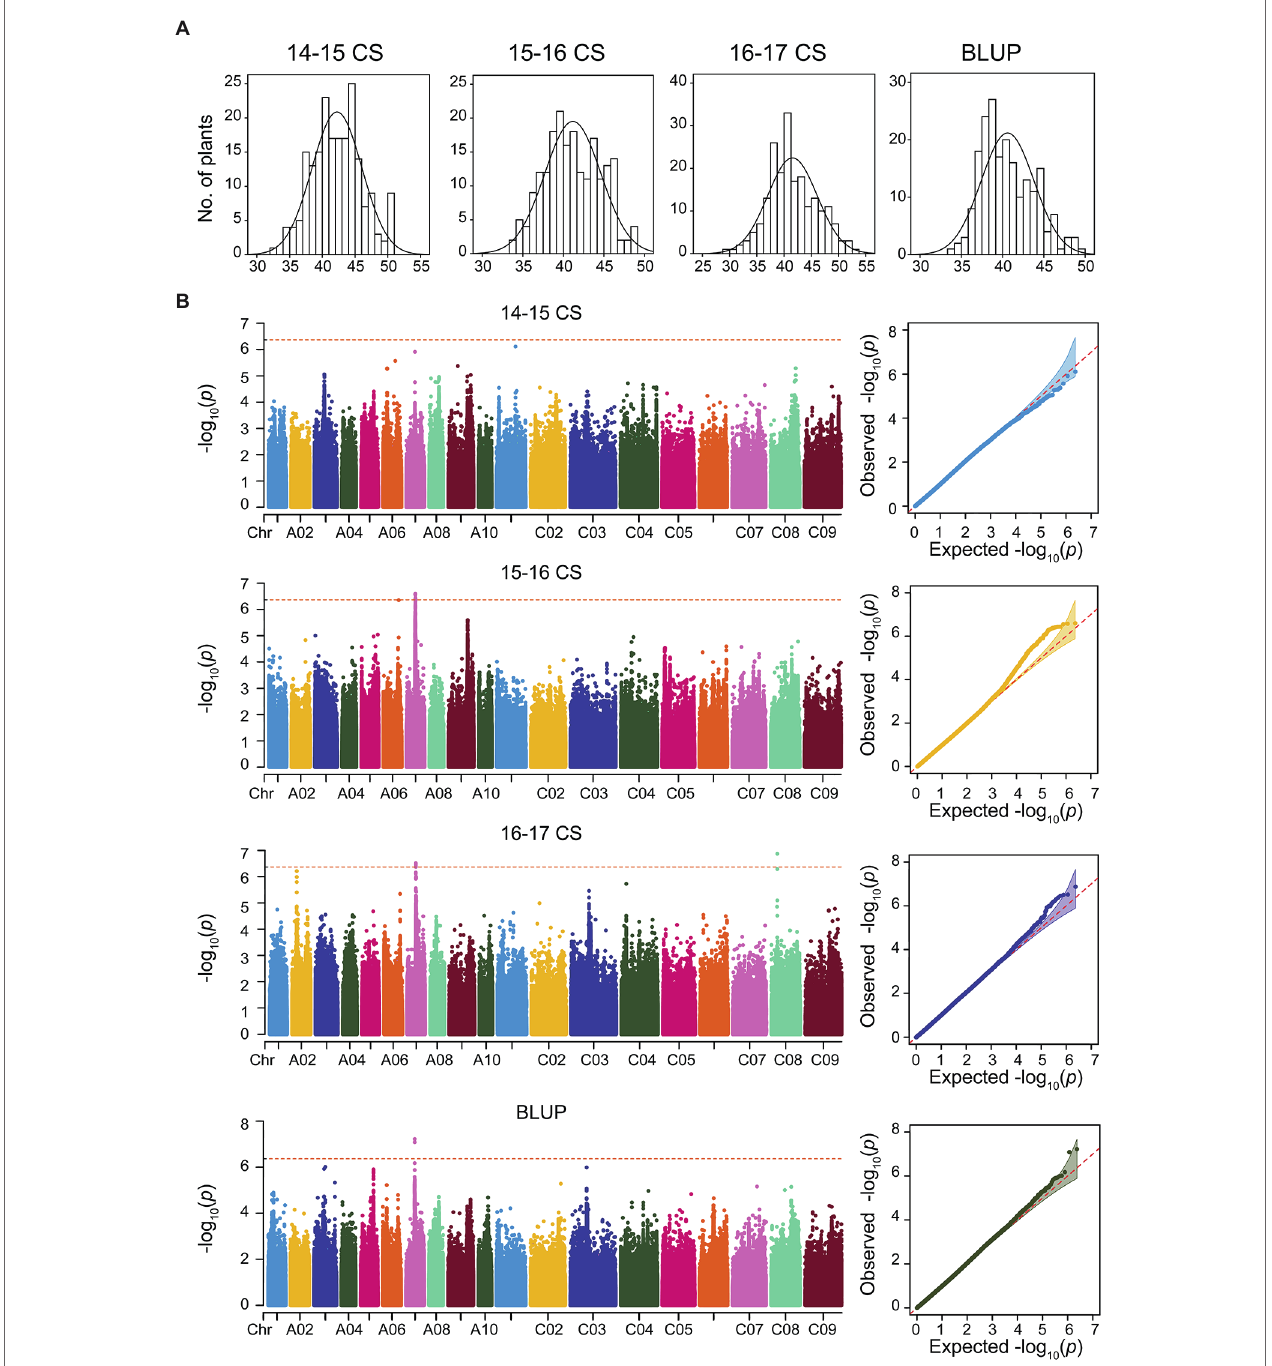
FIGURE 1 | Genome-wide association analysis (GWAS) for the seed oil content (SOC) trait in consecutive 3 years based on Mixed Linear Model (MLM) of Efficient Mixed-Model Association eXpedited (EMMAX). (A) The phenotype distributions of SOC in consecutive 3 years and best linear unbiased prediction (BLUP). (B) GWAS and Q-Q plot for SOC in consecutive 3 years and